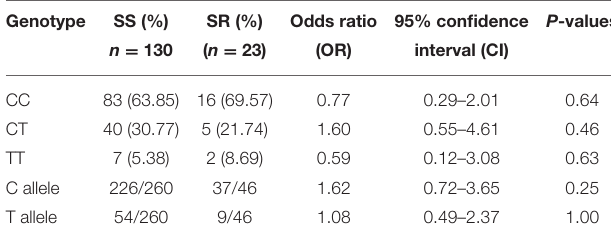
TABLE 3 | Comparison of IL-4 gene polymorphism genotype and allele frequencies between steroid sensitive (SS) and steroid resistant (SR) Kuwaiti INS